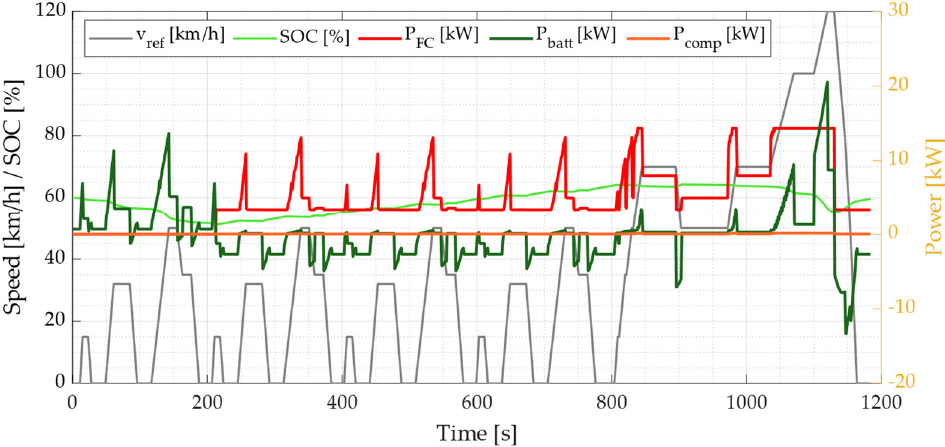
Figure 10. Simulation conducted on NEDC driving cycle with baseline mode-based control strategy.